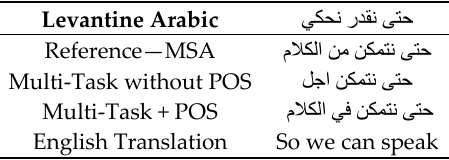
Table 6. Translation examples for Levantine.